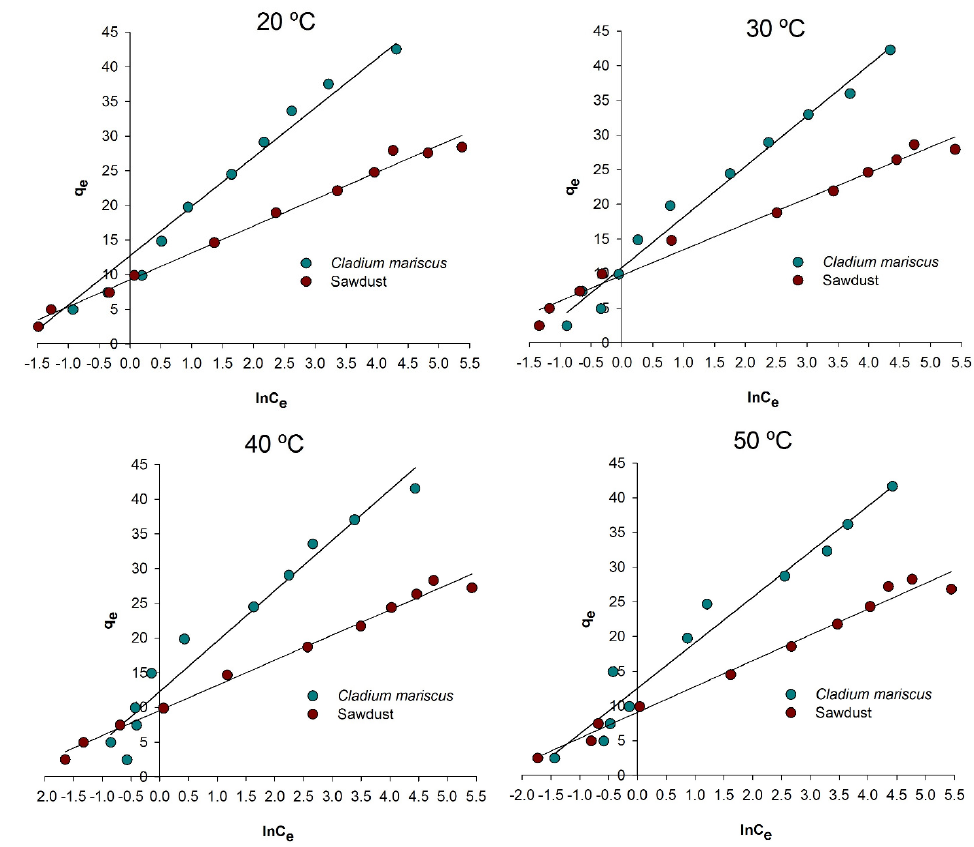
Figure 7. Temkin isotherm model for BB3 adsorption on sawdust and Cladium mariscus saw-sedge at different temperatures. Table 4. Isotherm constants for BB3 adsorption on sawdust and Cladium mariscus saw-sedge at 20– 50 °C.